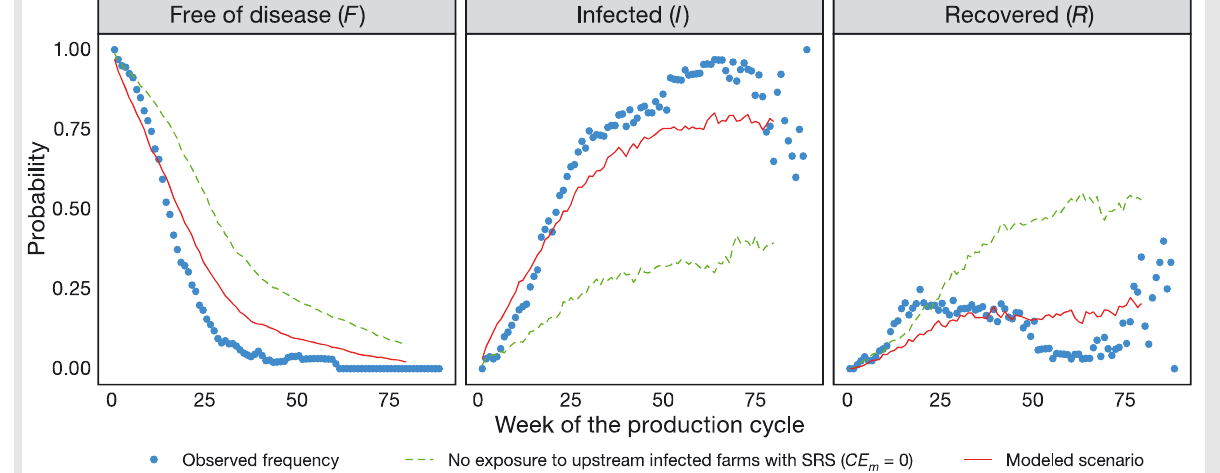
Figure 5. Piscirickettsiosis dynamics as a function of the week of the salmon farming cycle for the SIMA Chile system, showing predicted (lines) and observed (dots) exposure scenarios. In both cases, temperature, salinity, and stocking week of the farm were assumed to be constant. Adapted from [50].